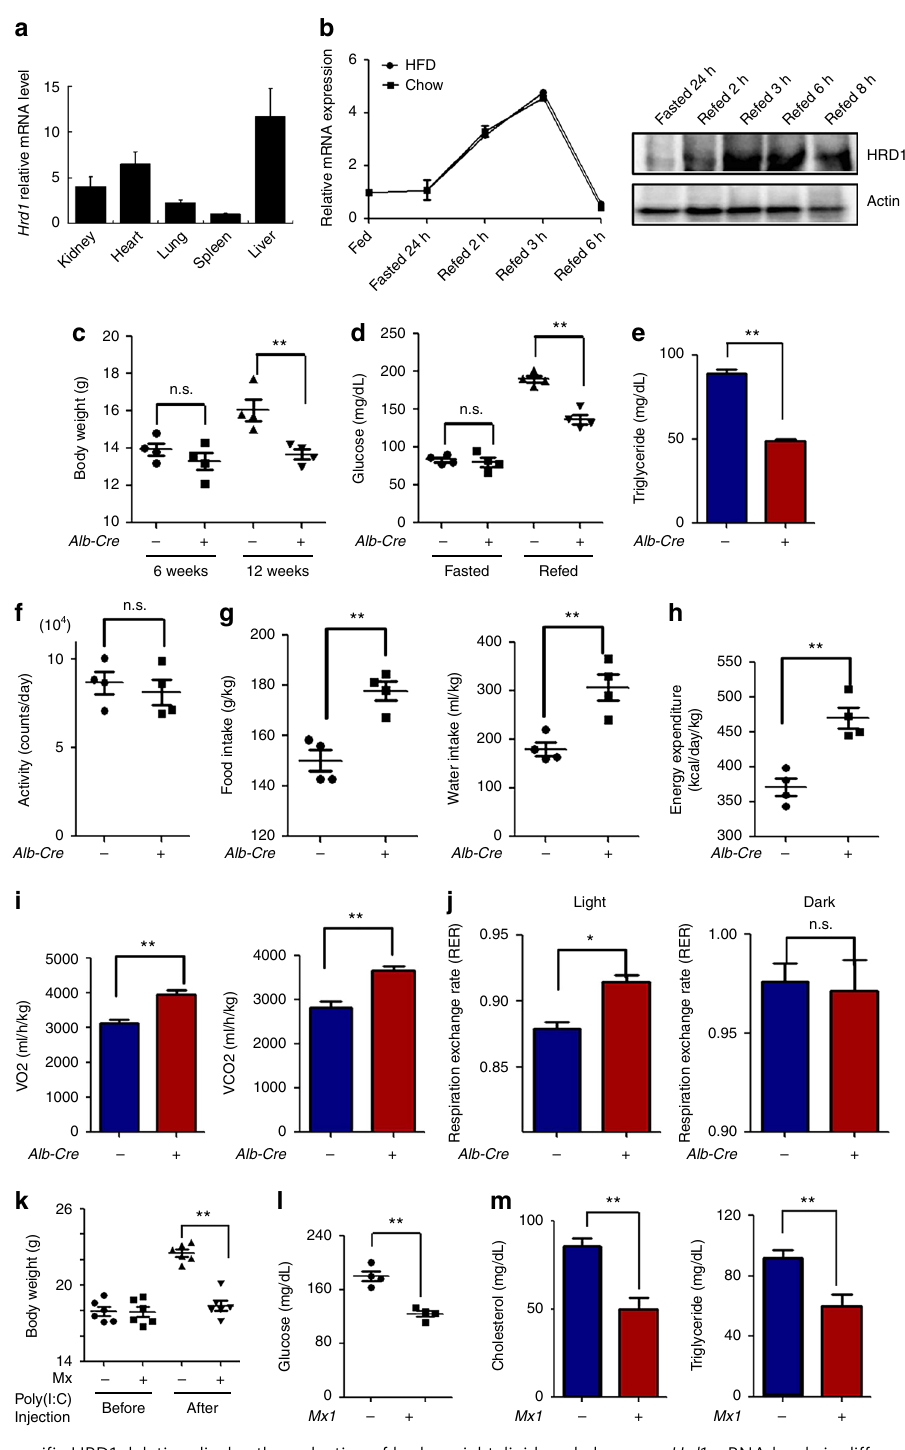
Fig. 1 Mice with liver-speci fi c HRD1 deletion display the reduction of body weight, lipid, and glucose. a Hrd1 mRNA levels in different organs. b Hrd1 mRNA and protein levels under fasted and refed conditions. c Body weights of WT and HRD1 Alb mice at weeks 6 and 12 ( n = 4 for each group). d Blood glucose levels of WT and HRD1 Alb mice under fasted and refed conditions ( n = 4 for each group). e Serum TG of WT and HRD1 Alb mice under refed conditions ( n = 6 for each group). f Activities of WT and HRD1 Alb male mice ( n = 4 for each group). g Food intake, water intake, and body weight ratios of WT and HRD1 Alb mice ( n = 4 for each group). h Energy expenditure and body weight ratios of WT and HRD1 Alb mice ( n = 4 for each group). i O 2 consumption and CO 2 production of WT and HRD1 Alb mice fed a standard chow diet ( n = 8 for each group). j RER of WT and HRD1 Alb mice fed a standard chow diet ( n = 8 for each group). k Body weight of the HRD1 F/F and HRD1 F/F Mx1-Cre + mice ( n = 6 for each group) before and 1 month after polyI:C injection. l Blood glucose was measured 7 days after polyI:C injection in the refed condition. m Serum cholesterol and TG level were measured 7 days after polyI:C injection under refed conditions ( n = 6 for each group). Data are representative of three independent experiments (mean ± s.d.). * P < 0.05. ** P < 0.01 by unpaired Student ’ s t